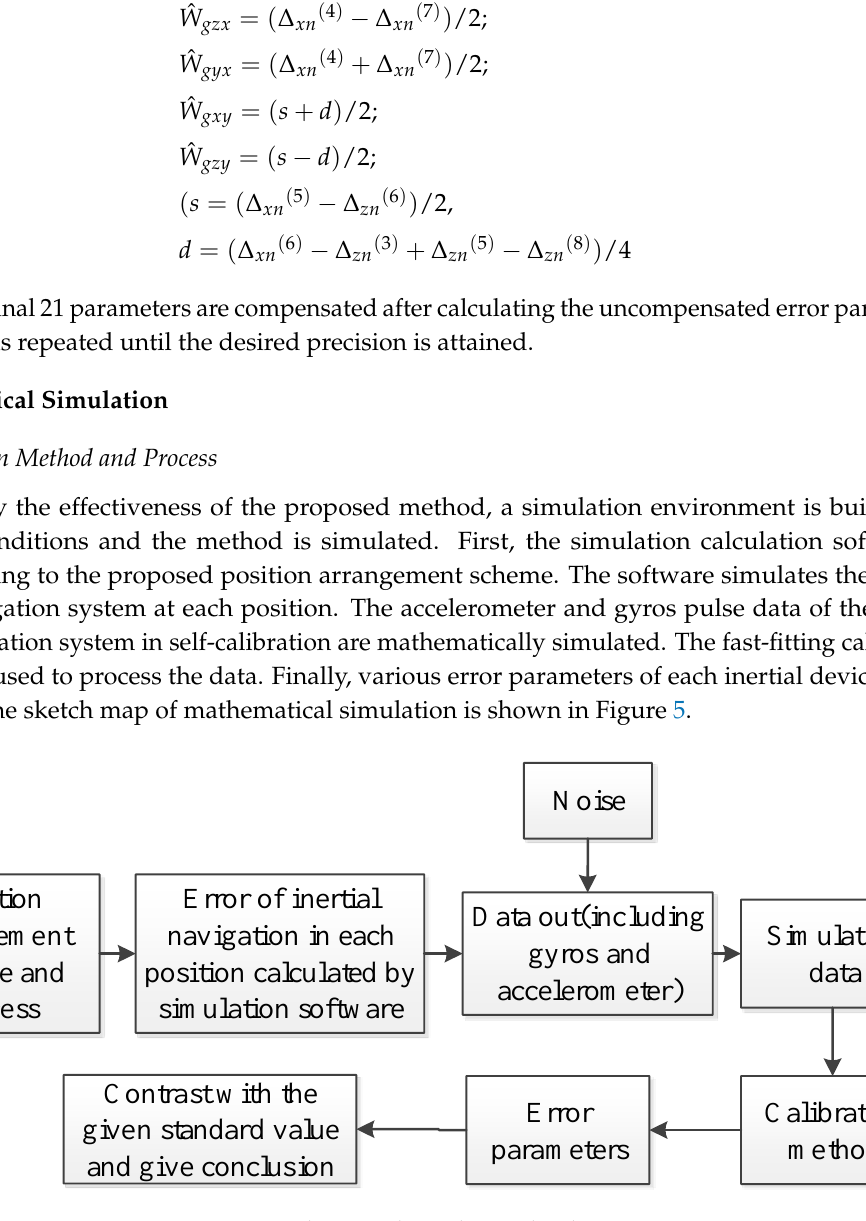
Figure 5. Mathematical simulation sketch map.